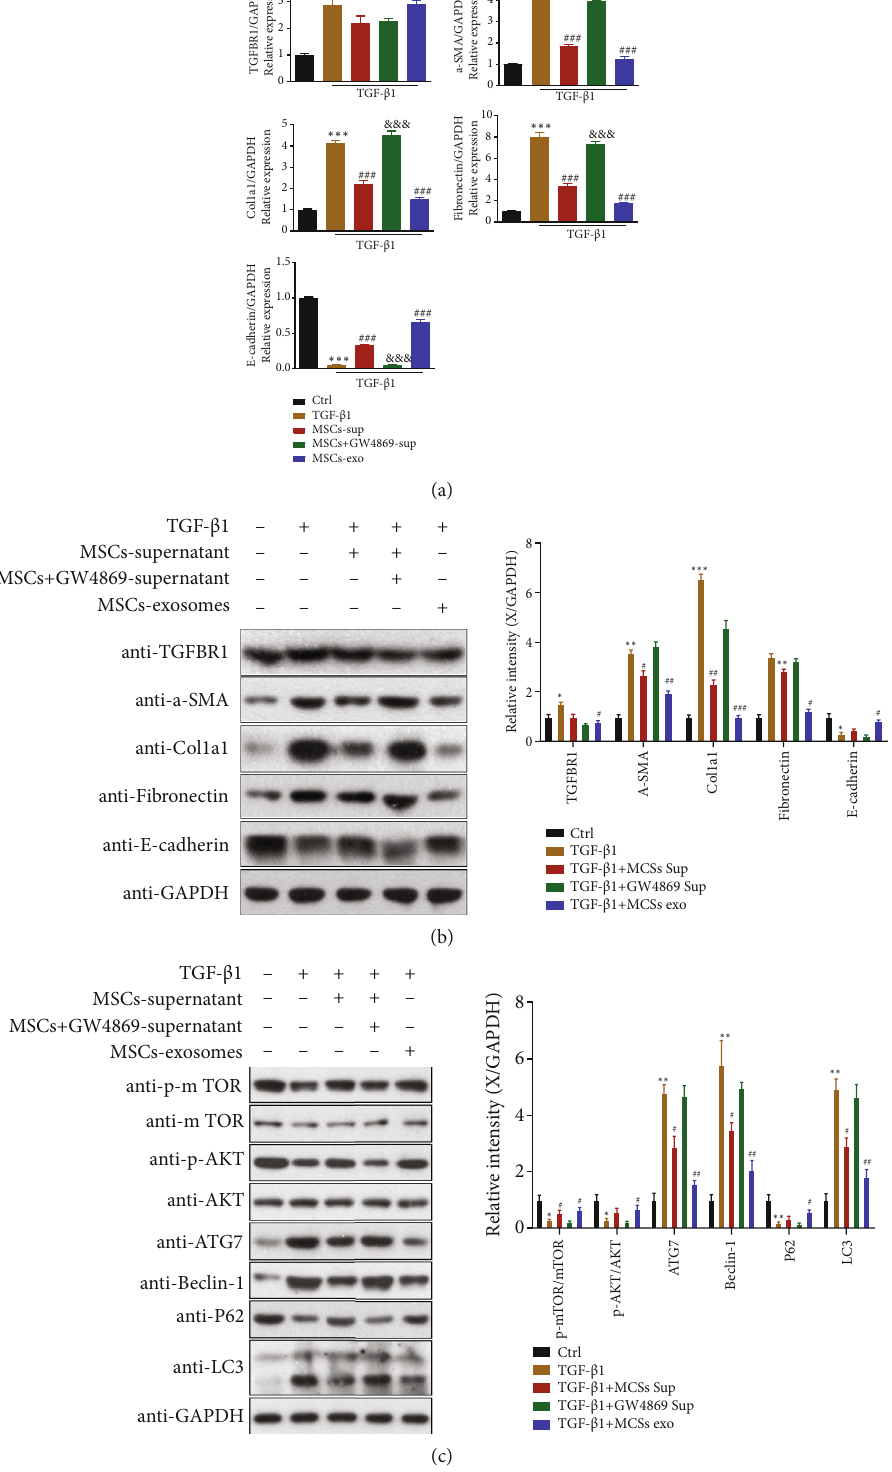
Figure 1: MSC-derived exosomes relieve fi brosis caused by TGF β in HK-2 cells via regulation of mTOR signaling and downstream autophagy. (a) TGFBR1, α -SMA, Col1a1, fi bronectin, and E-cadherin mRNA levels were evaluated by qPCR in HK-2 cells. (b) Immunoblotting analysis for TGFBR1, α -SMA, Col1a1, fi bronectin, and E-cadherin expression in HK-2 cells. Quantitative analysis of TGFBR1, α -SMA, Col1a1, fi bronectin, and E-cadherin expression is shown on the right ( n = 3 independent experiments). (c) LC3 II/I, p62, Beclin 1, ATG7, mTOR, p-mTOR, AKT, and p-AKT protein expression was evaluated by western blotting in HK-2 cells, and the quantitative analysis is shown on the right ( n = 3 independent experiments). Results are expressed as the mean ± SEM . ∗∗∗ P < 0 : 001 , ∗∗ P < 0 : 01 , and ∗ P < 0 : 05